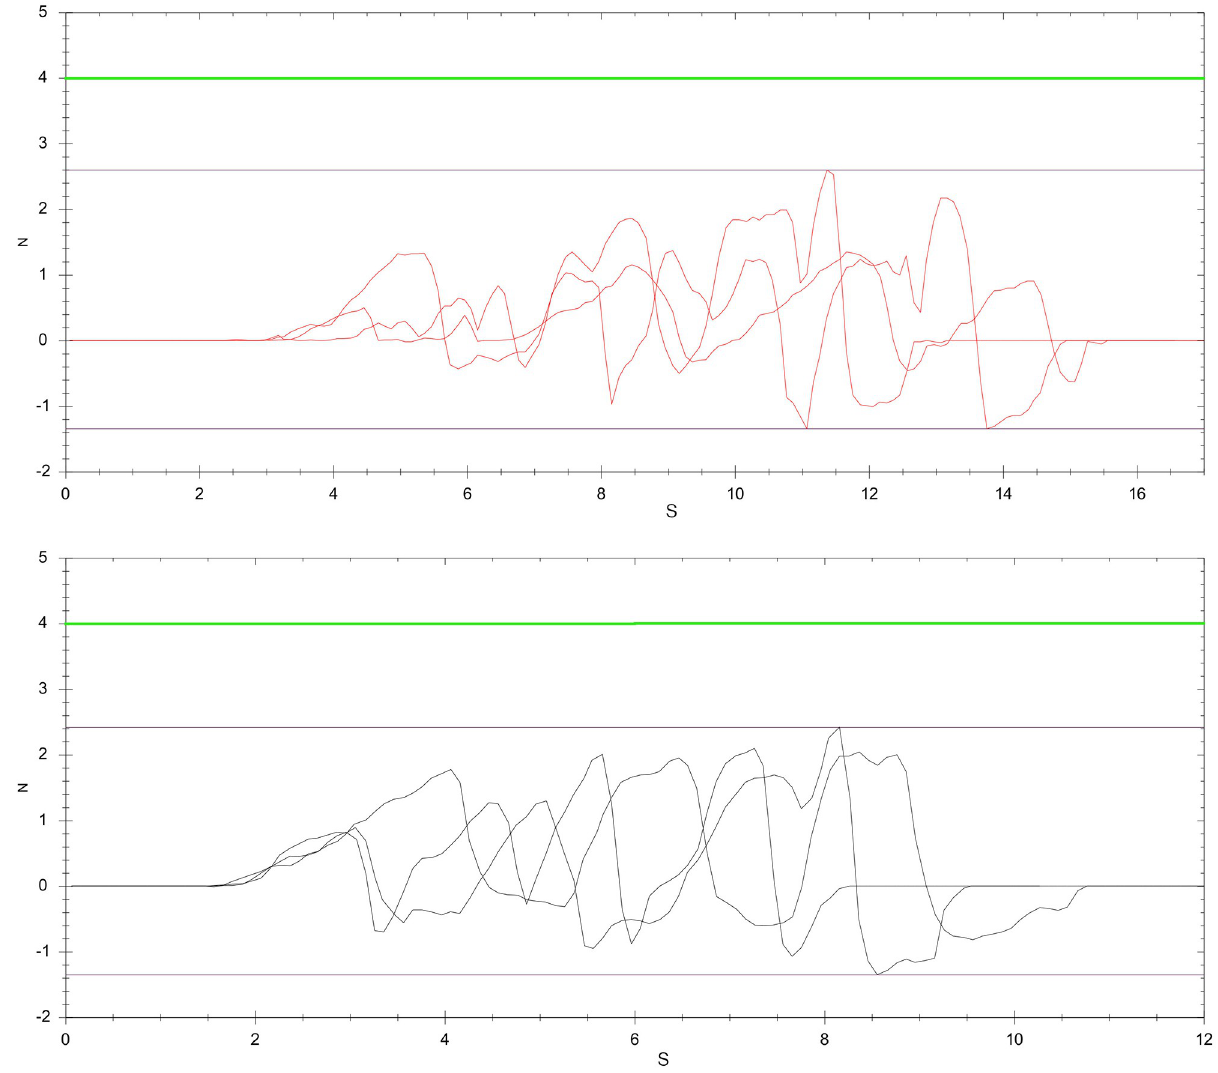
Fig 1. Axial forces applied during root canal preparation of one specimen with peak values less than 4 N. Red: 25/.06; black: 40/.06.